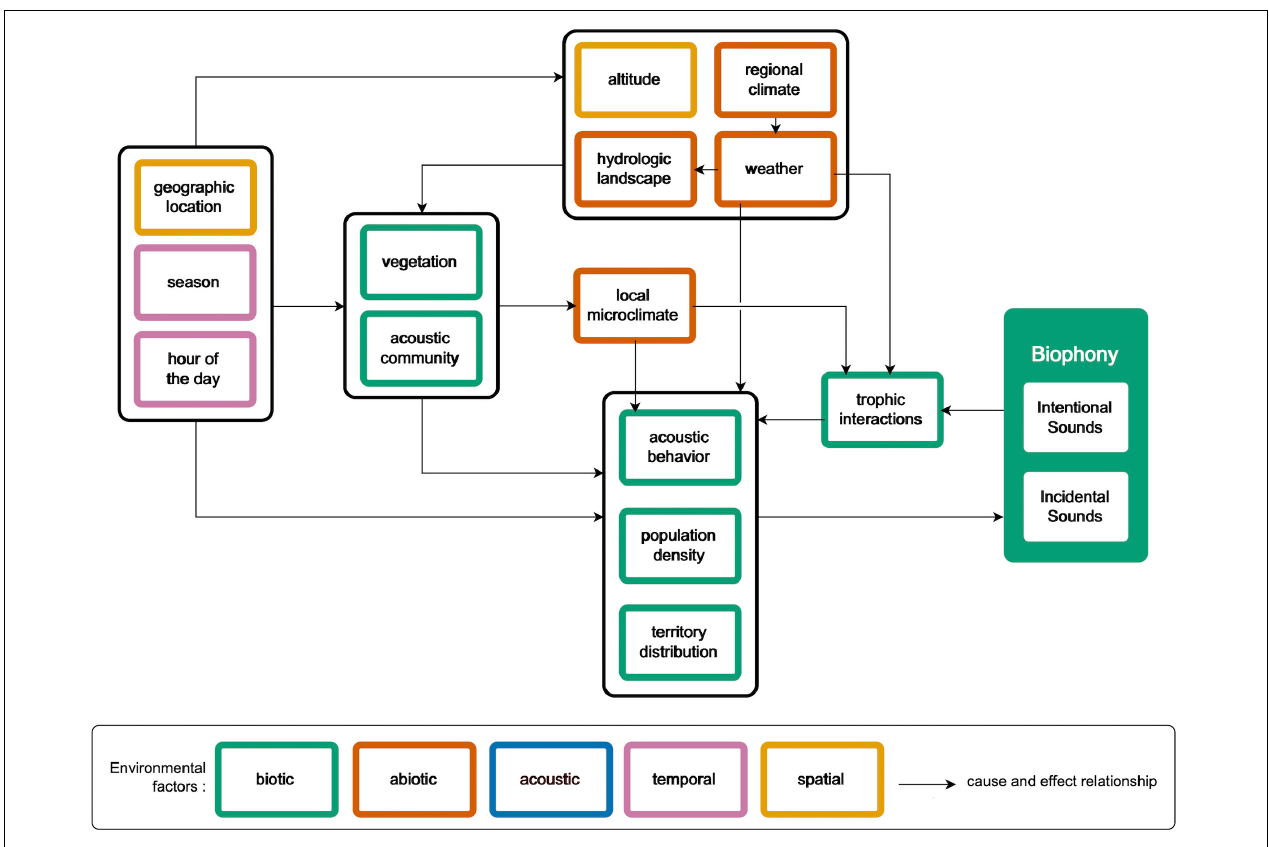
FIGURE 3 | Detailed soundscape functional block diagram: focus on